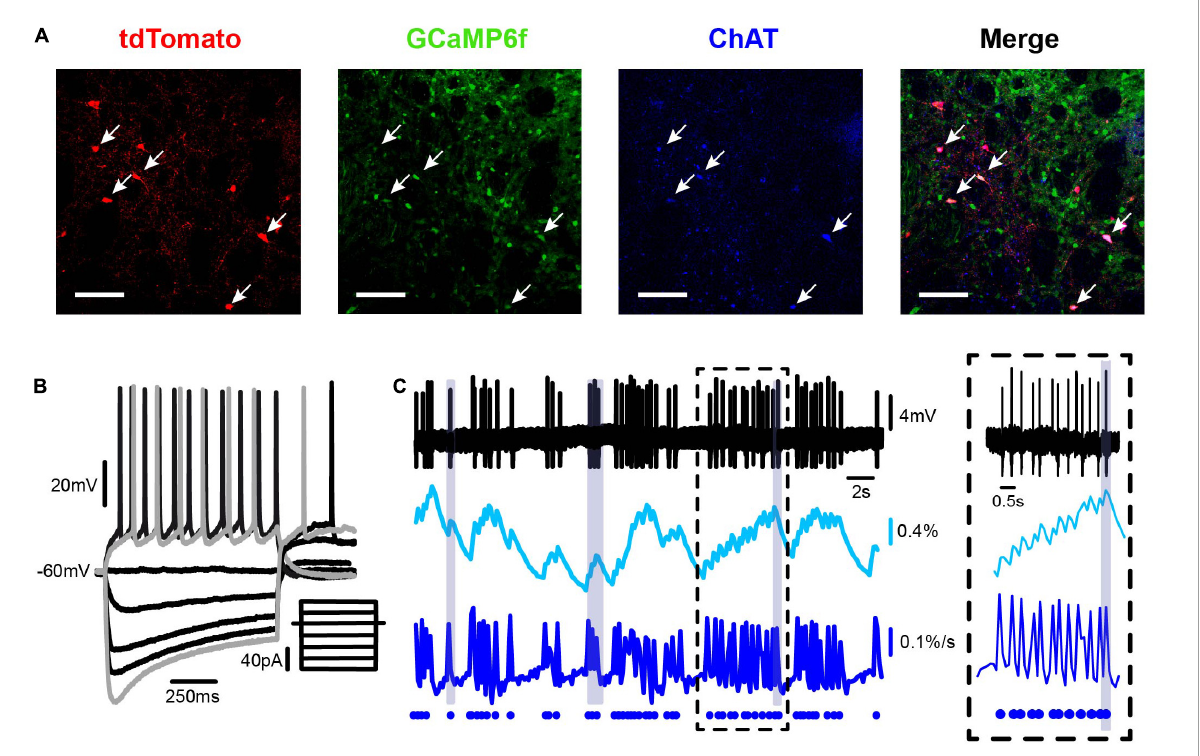
FIGURE3 Simultaneous electrophysiological and calcium imaging recording of a striatal cholinergic interneuron. (A) Panels show from left to right: a double-photon micrograph of neurons expressing tdTomato (red), the same field showing neurons expressing GCaMP6f (green; under the synapsin promoter), neurons immunoreactive to anti-ChAT antibodies (blue), and the merge of previous panels showing that ChAT neurons correspond to the ones with tdTomato. (B) Whole-cell current clamp recording of a representative striatal CIN showing voltage responses to 1 s depolarizing and hyperpolarizing current injections at the soma: firing, inward rectification (“sag”), and rebound (inset illustrates stimulus currents from –80 to 30 pA in 10 pA steps). (C) Simultaneous on-cell extracellular recording of a spontaneous firing CIN (top), its corresponding calcium transients ( (cid:49) F/F0; 2nd trace), and inferred electrical activity from calcium fluorescence [d( (cid:49) F/F0)/dt: third trace]. Dots at the bottom trace represent the way the inferred electrical activity is illustrated in the raster plots as in Figure 1 . A neuron with bursts and pauses is shown to compare real (top) with inferred activity (bottom). Inset: zoom of recording at a time within the dashed